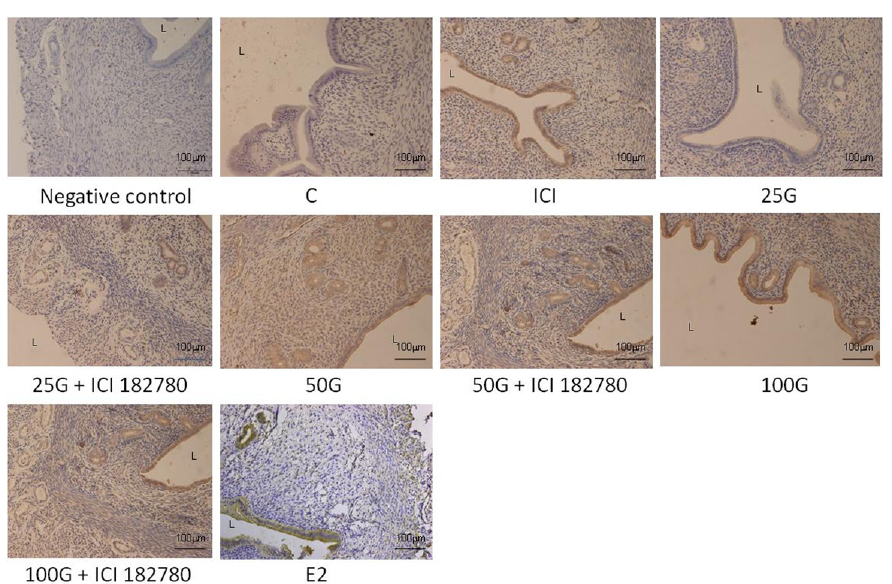
Figure 8. The distribution of NBCe1-B in the uterus of rats treated with various doses of genistein (25, 50 and 100 mg/kg/day with and without the presence of ICI 182780, an estrogen receptor antagonist). An increase in intensity of NBCe1-B immunostaining was seen mainly at the apical membrane of the luminal and glandular epithelia with increasing doses of genistein. The highest intensity was observed following treatment with estrogen followed by 100 mg/kg/day genistein. Concomitant administration of ICI 182780 caused a decrease in immunostaining intensity. C: control; ICI: ICI 182780; 25G: 25 mg/kg/day genistein; 50G: 50 mg/kg/day genistein; 100G: 100 mg/kg/day genistein; E2; estrogen. n = 4 rats per group. Images were taken at 20× magnification. L: